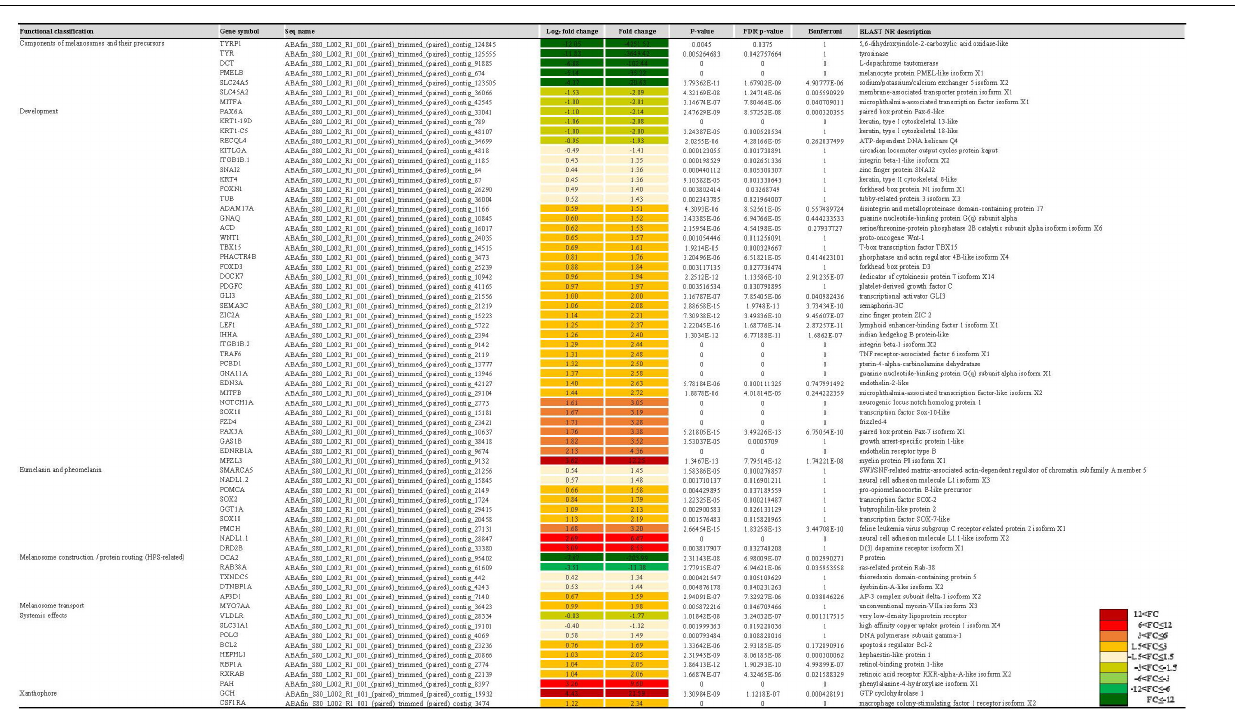
FIGURE 4 | The list of pigmentation-related genes by functional classification, expression profiles, and statistical information. The FC value of gene expression shows by color from green series (down-regulation) to red series (up-regulation).